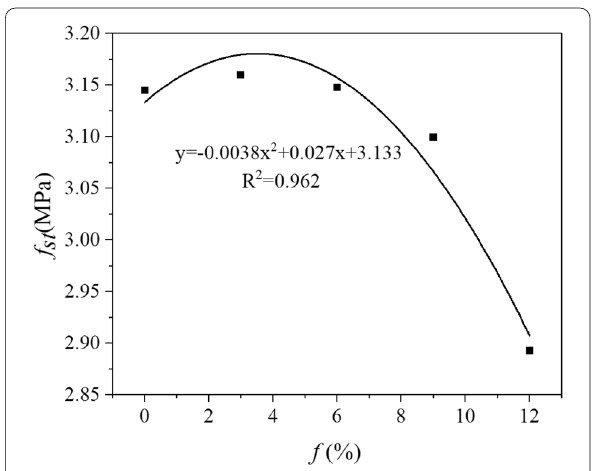
Fig. 21 Curve of concrete tensile strength with silica fume content in interfacial agent